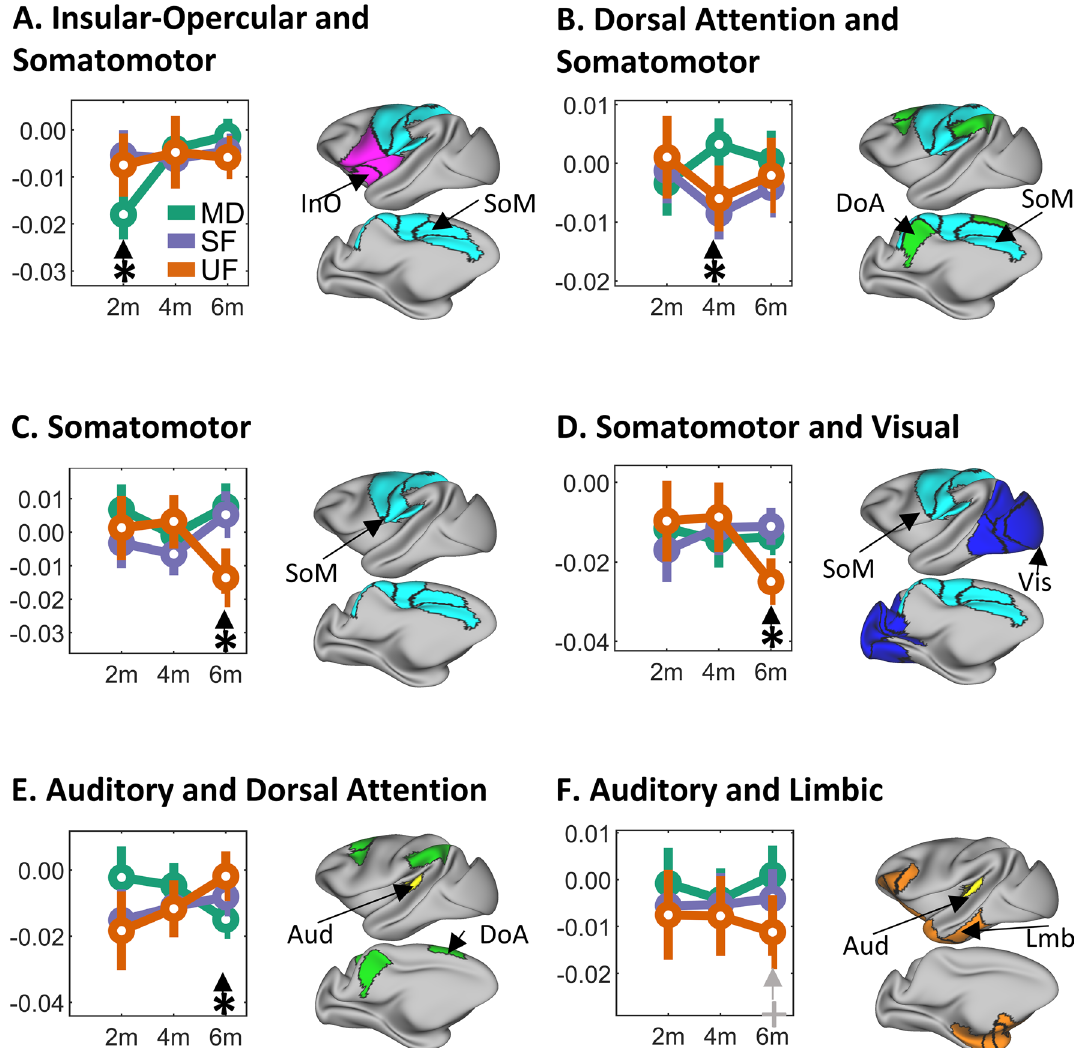
Figure 2. Functional network pairs with significant differences in functional connectivity for the interaction of group (MD, SF and UF) and age (2 m, 4 m, 6 m). Circles represent the mean functional connectivity and the bar indicates the interquartile range. Each plot indicates the p-value for each individual repeated measures ANOVA test. Each panel also includes a highly inflated projection of the brain cortex with left-lateral and left-medial views indicating the location of the corresponding functional network